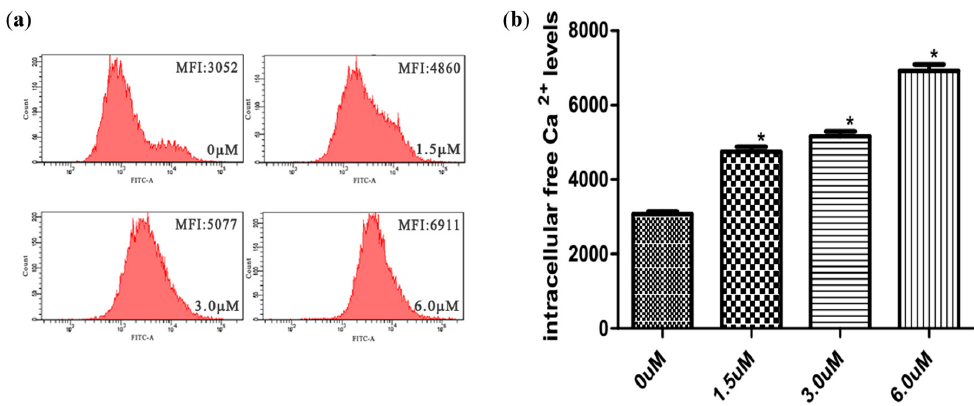
Figure 5. Effect of 3g on intracellular-free Ca 2+ levels in HSCs. Values are expressed as the mean ± SD in each group ( n = 3). * p < 0.001 vs. 0 µM.